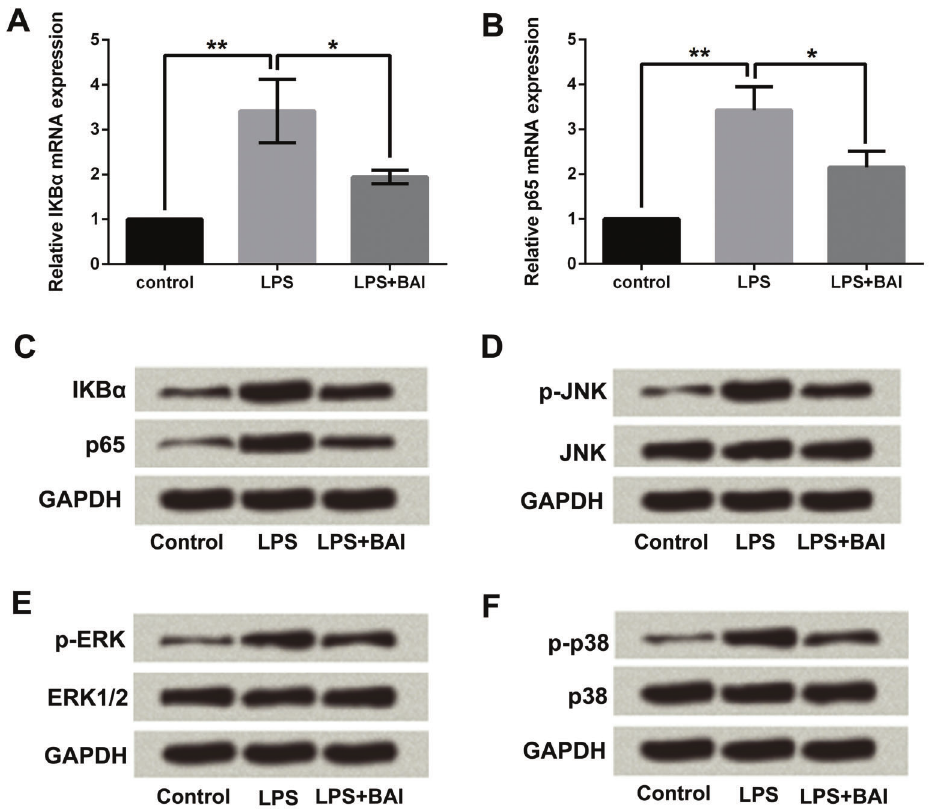
Figure 4. A and B , Effect of BAI on LPS-induced mRNA expression of I k B a and p65 increase in RPTECs. C , Representative western blotting images of protein expressions of I k B a and p65; D – F , protein expressions of p-JNK, p-ERK, and p-38. BAI: baicalein; LPS: lipopolysaccharide; RPTECs: renal proximal tubular epithelial cells; NF- k B: nuclear factor kappa B; MAPK: mitogen-activated protein kinase; I k B a : inhibitor of NF- k B; JNK: c-Jun N-terminal kinase; ERK: extracellular regulated protein kinases. Data are reported as means ± SE. *P o 0.05; **P o 0.01